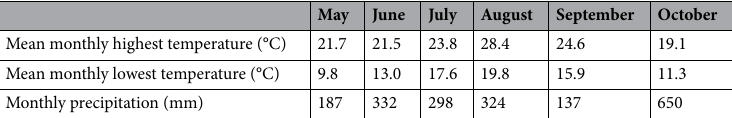
Table 1. Nikko botanical garden weather data (May–October